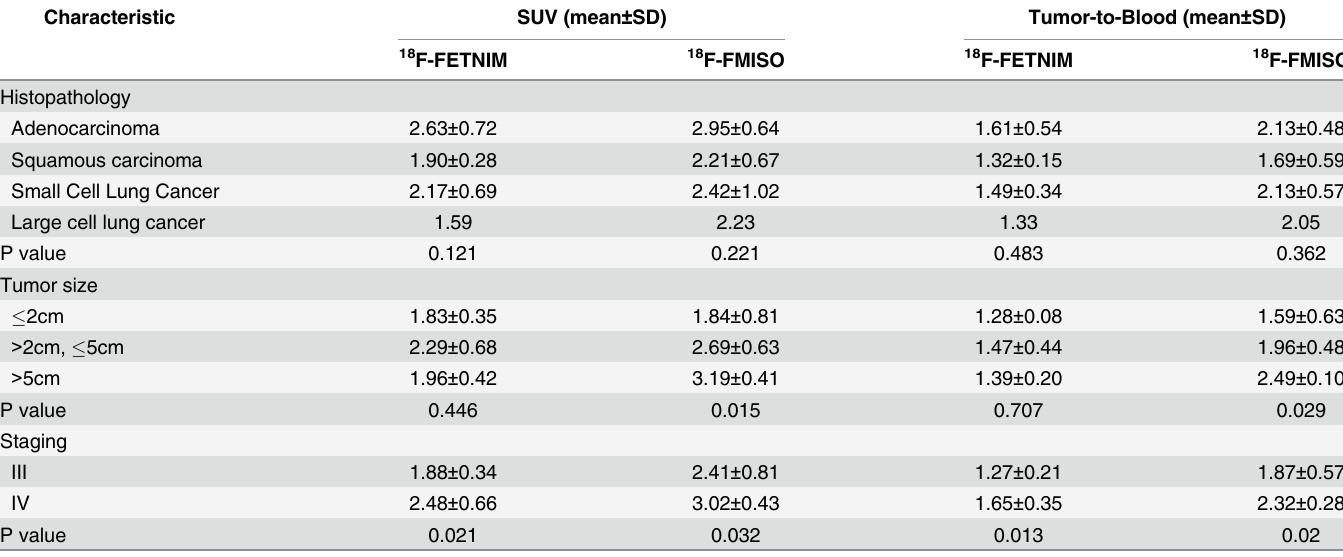
Table 3. Semiquantitative Assessment of 18 F-FETNIM and 18 F-FMISO Uptake in Tumor Under Different Conditions.